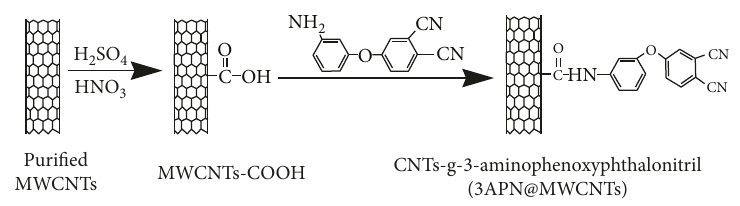
Figure 8: Schematic illustration of preparation of